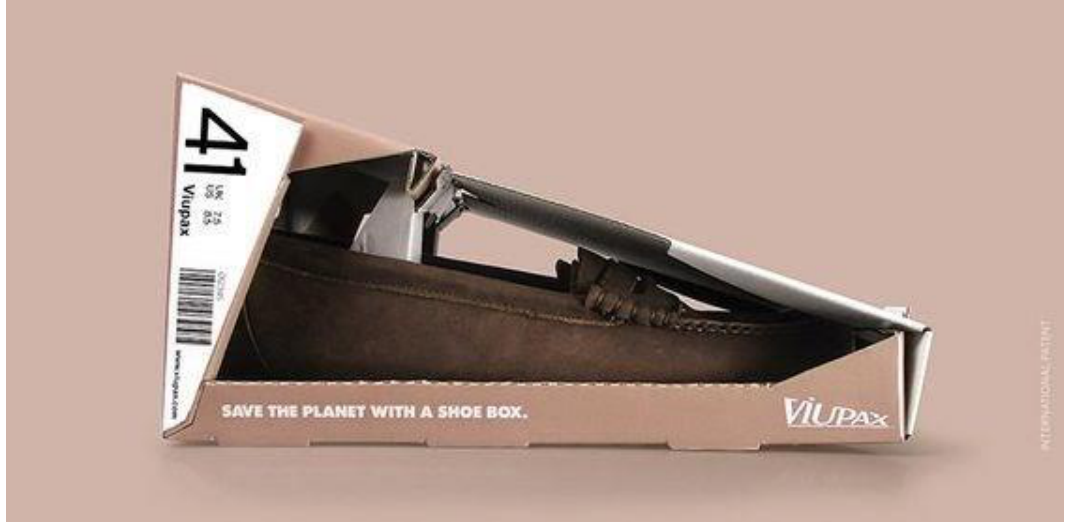
Figure 4: New solution for shoes packaging made by Viupax